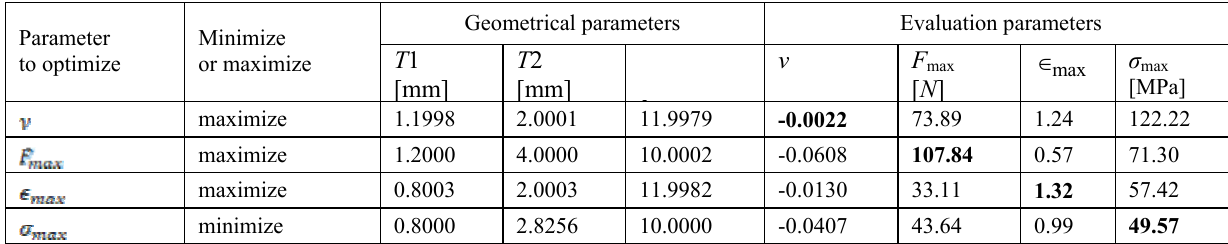
Geometrical parameters Evaluation parameters